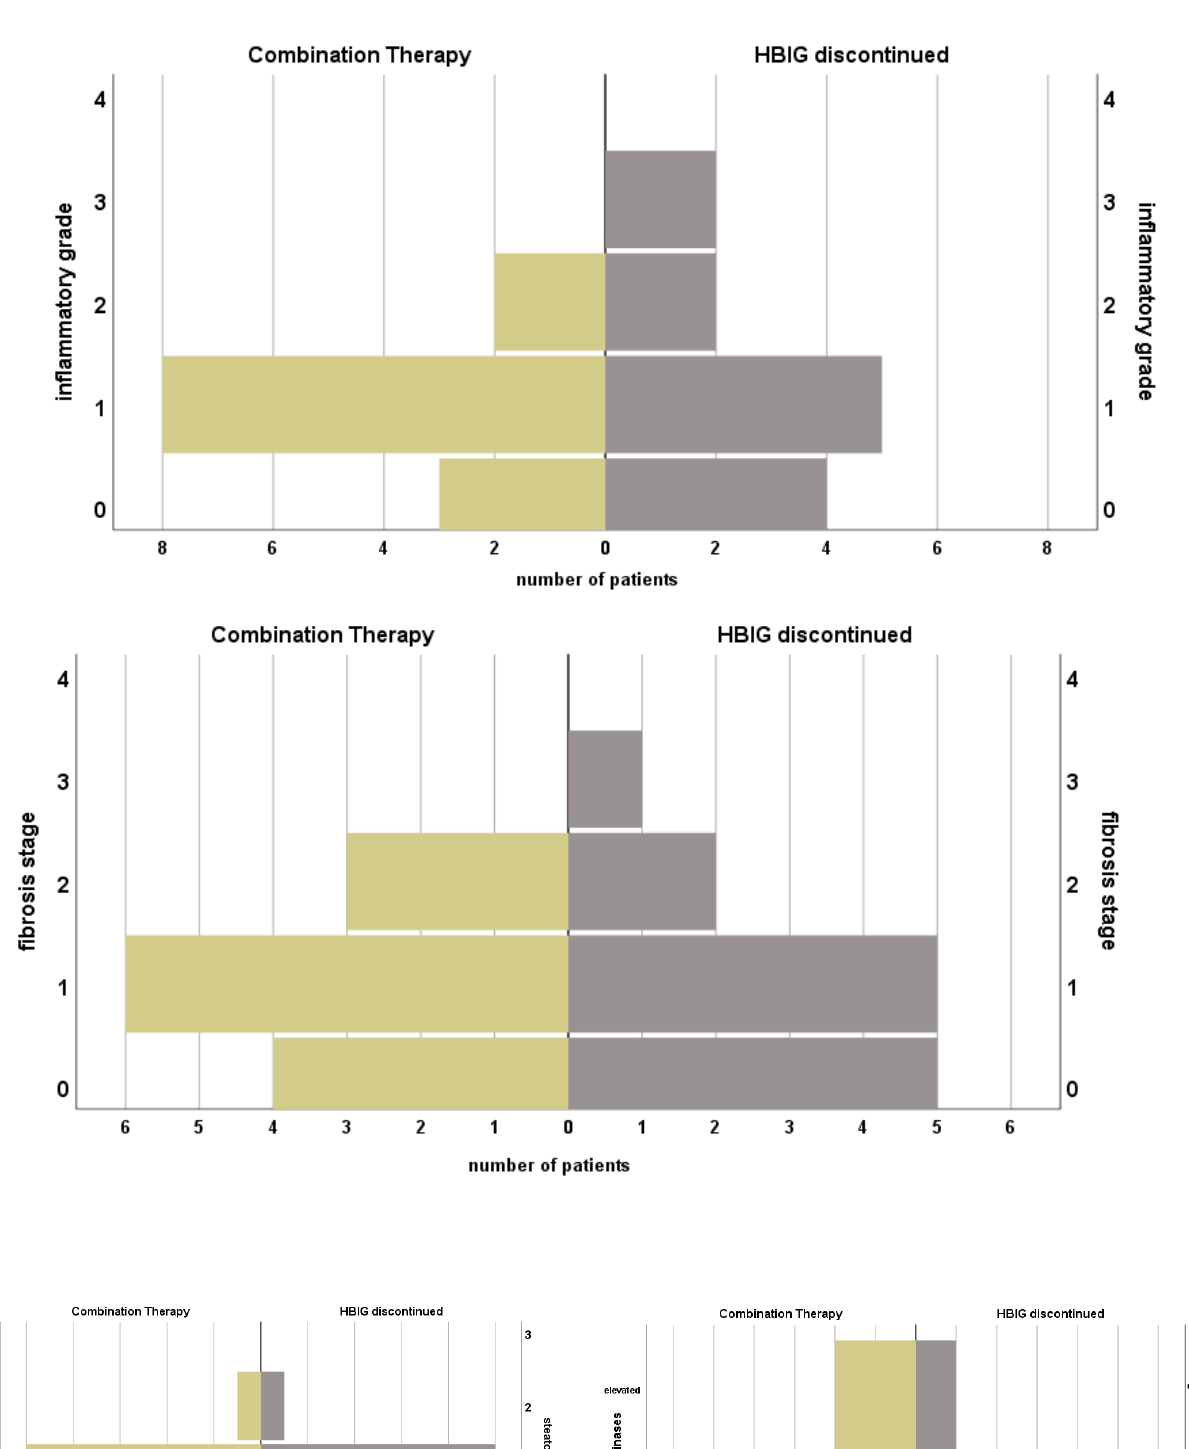
Figure 2. Histopathological findings and level of transaminases of patients with or without continuous HBIG prophylaxis for combined HBV/HDV infection before liver transplantation. Group standard—life-long combination of HBIG with NA; group discontinuation—discontinuation of HBIG.